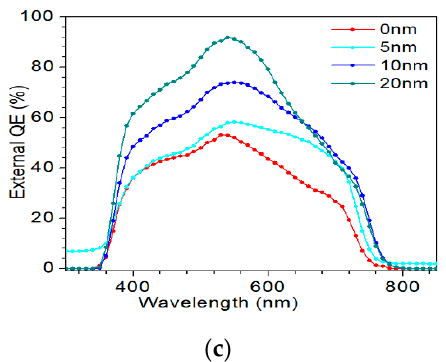
Figure 14. Performance of AIGS champion solar cells: ( a ) J–V curves as a function of Na 2 Se thickness; ( b ) light and dark J–V curve of AIGS solar cell with 20 nm Na 2 Se; ( c ) quantum efficiency as a function of Na 2 Se thickness.